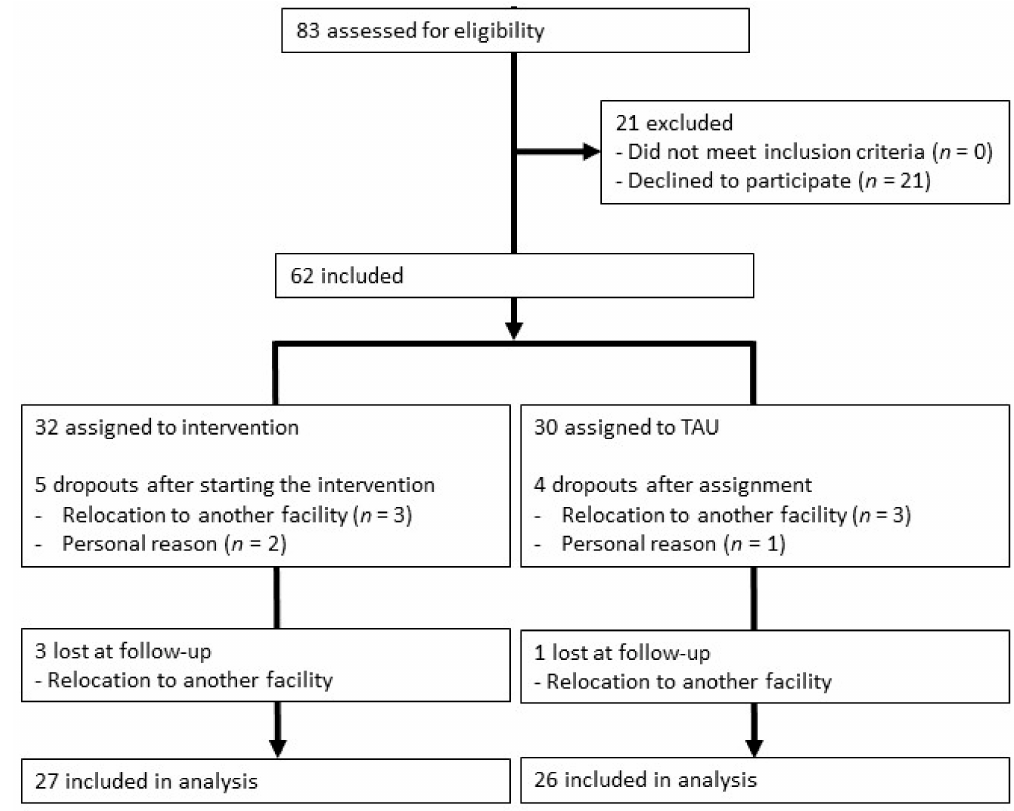
Figure 1. CONSORT flow